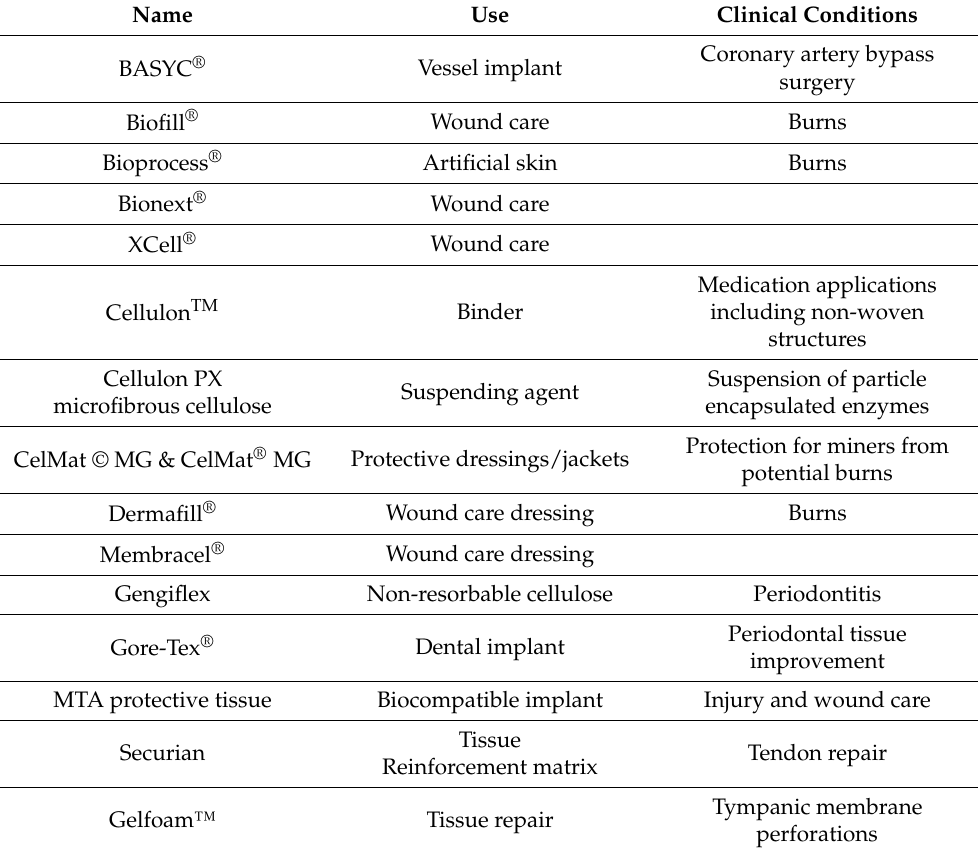
Table 1. Some commercial BC composites